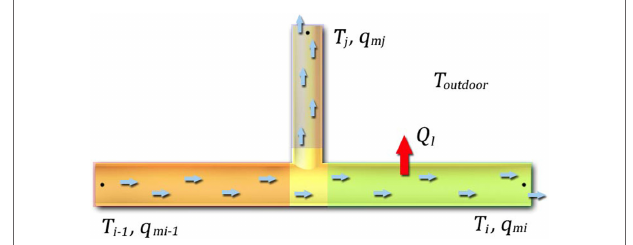
FIGURE 5 | Heat flow in the piping system